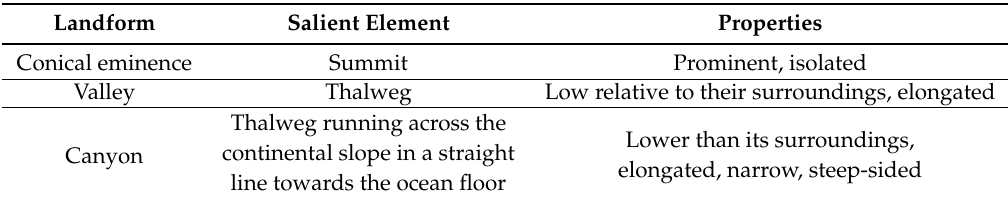
Table 3. Summary of the characteristics identified for each